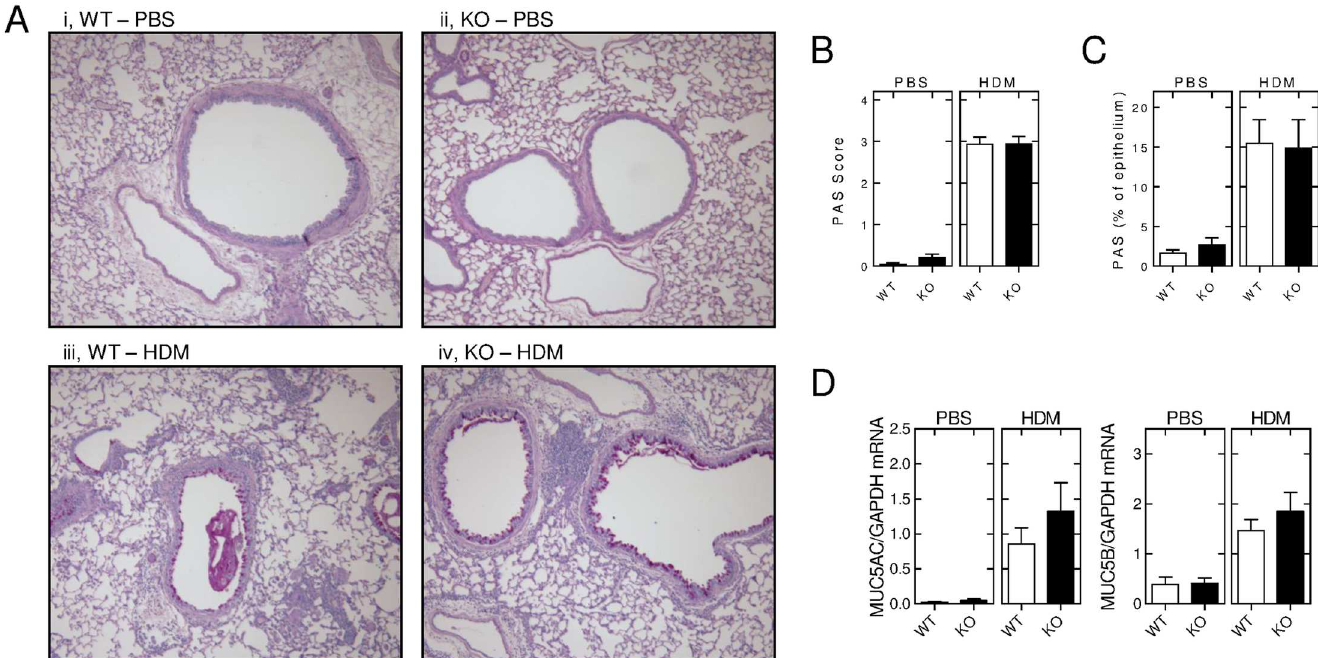
Fig 4. Effect of RGS2 deficiency on HDM-induced mucus secretion. Wild type (WT) and Rgs2 -/- (KO) mice were subjectedto i . n . instillationof PBS or HDM (25 μ g) 3 times/week for 3 weeks. A, Lungswere dissected, inflated and fixed in 10% formalin and embedded in wax. Sections were stained with PAS to allowvisualizationof mucus. B, PAS-stained sections were scored using a semi-quantitative scoringsystem where a score of 4 indicatedstrong staining(more than 75% of the airway epitheliumPAS positive), 3 = moderate staining(50–75%of the airway epitheliumPAS positive), 2 = mild staining (25–50%of the airway epitheliumPAS positive), and a score of 1 = minimalstaining(less than 25% of airway epithelium PAS positive). Data ( N = 17 for PBS-exposed wild type and 15 for Rgs2 -/- , N = 29 for HDM-exposed wild type and 24 for Rgs2 -/- ) are plotted as means ± SE. C, Image J software was used to measurethe amount of mucus secreted from the airway epitheliumand all measurements were made by an investigatorblindedto the study treatments. Data (all N = 8) are plotted as means ± SE. D, RNA was extracted from the right lungs and mucin geneexpressionanalyzedby qPCR. Data ( N = 23 for PBS-exposed wild type and 22 for Rgs2 -/- , N = 34 for HDM-exposed wild type and 29 for Rgs2 -/- ), normalizedto GAPDH, are plotted as means ±